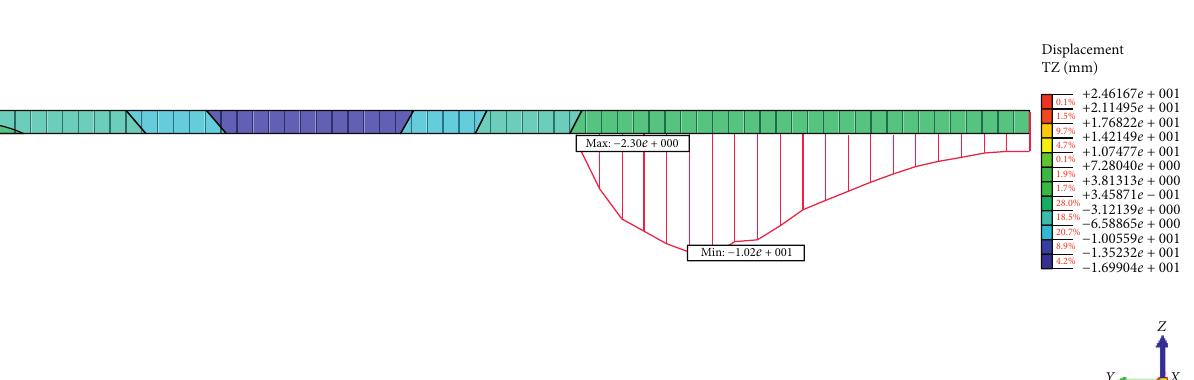
Figure 7: Settlement of the surrounding ground when the foundation pit is excavated to the bottom. (a) Horizontal displacement of the underground diaphragm wall adjacent to the existing station. (b) Horizontal displacement of the underground diaphragm wall away from the existing station.